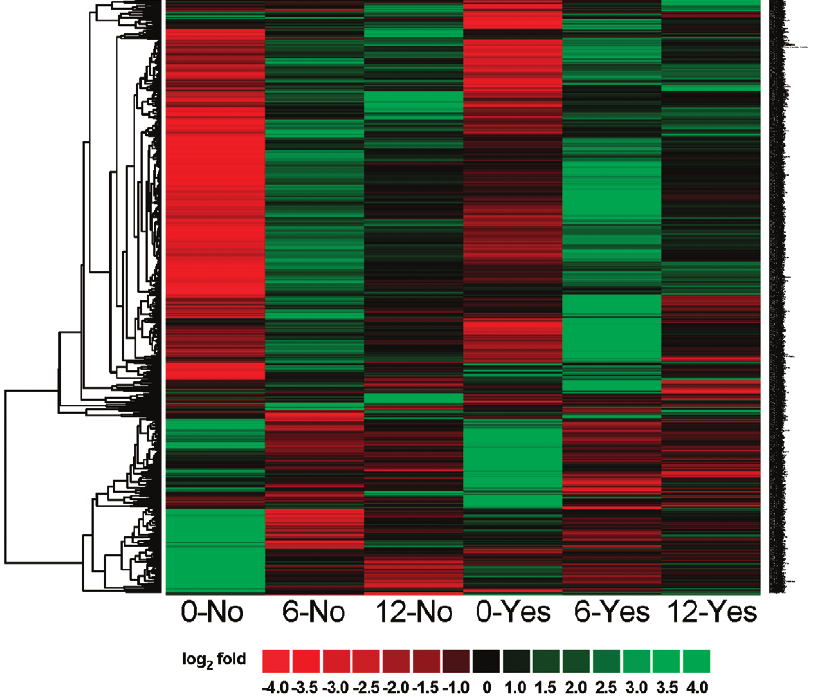
Figure 3. Heat map displaying hierarchical clustering results from microarray expression profile data derived from skeletal muscle RNA pools. Samples include 0, 6 and 12 months ‘‘No’’ omentectomy and 0, 6 and 12 months ‘‘Yes’’ omentectomy. The expression of 2,697 genes is represented as a dendrogram after applying filtering criteria for selecting genes with a log 2 ratio intensity greater than 1 (ratio . 2). Gene expression ratios are displayed by applying progressively brighter shades of red (down-regulated) or green (up-regulated) to log 2 ratios that increasingly deviate from zero.